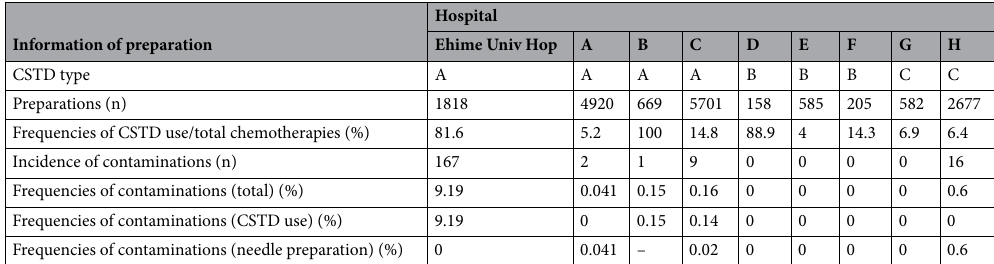
Table 2. Summary of frequencies of contaminations at institutes providing chemotherapies in Ehime